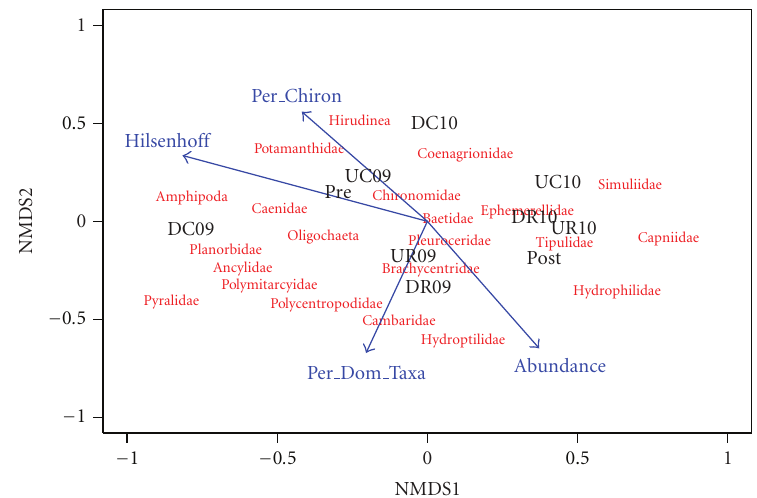
Figure 2: Nonmetric multidimensional scaling (NMDS) ordination plot for aquatic macroinvertebrate communities at all sampling reaches (stress = 10.6 for 2-dimensional solution) in the Cacapon River, WVa, USA. Reaches are labeled by reach category: upstream control (impaired reach, but not receiving restoration) denoted “UC”; downstream control denoted “DC”; upstream reference (unimpaired, natural reach) denoted “UR”; and downstream reference denoted “DR”. “Pre” denotes the restoration reach prior to restoration (2009), and “Post” denotes the restoration reach after restoration (2010). Selected macroinvertebrate taxa are positioned in the ordination as weighted averages. Vector lengths indicate relative correlative strength of macroinvertebrate community metrics ( P ≤ 0 . 05; 1000 permutations).